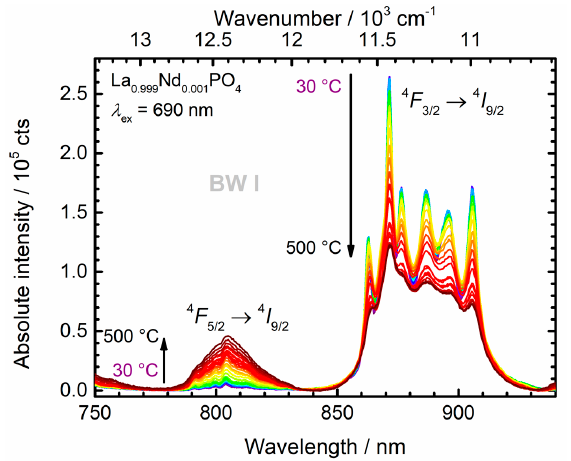
Figure 8. Exemplary temperature-dependent emission spectrum of La 0.999 Nd 0.001 PO 4 in the spectral range of the first biological window (BW I). The thermally coupled radiative transitions are indicated.